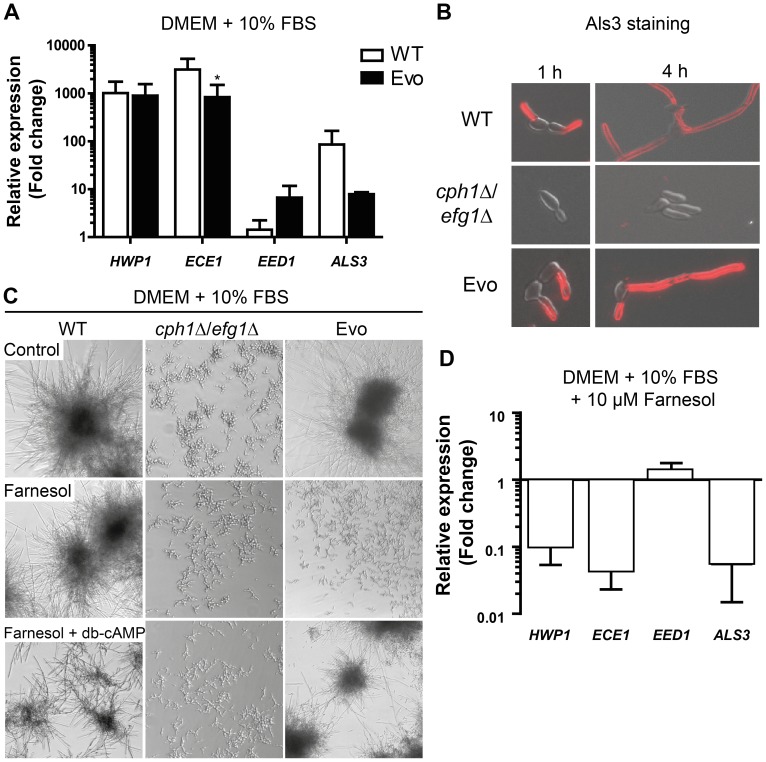
Analysis of hyphae-associated gene expression, Als3 surface expression and response to farnesol.(A) The Evo strain expresses hyphae-associated genes after growth for 1 h at 37°C at 5% CO2 on a plastic surface similar to WT. Relative gene expression of filament-inducing conditions was compared to yeast promoting conditions (YPD, 30°C) for three independent experiments. Expression was normalized against three housekeeping genes (ACT1, EFB1 and PMA1) and data are shown as mean+SD of three biological experiments (*p<0.05). (B) Immunofluorescence micrographs of cells immuno-stained for Als3 after growth in DMEM+10% FBS at 37°C and 5% CO2 on cover slips. Wild type (WT) and Evo cells are Als3-positive, while cph1Δ/efg1Δ cells show no signal (representative samples). (C) Morphogenetic response to farnesol treatment alone or in combination with exogenous dibutyryl-cyclic AMP (db-cAMP). All strains were exposed to either methanol (control), 1 µM farnesol or 1 µM farnesol+10 mM db-cAMP and incubated at 37°C and 5% CO2 for 18 h (representative pictures from three independent experiments are shown). Note that in Evo cells inhibition of filamentation by farnesol treatment was completely abrogated when db-cAMP was added. (D) Repression of hyphae-associated gene expression in the Evo strain by 10 µM farnesol. Expression was normalized against three housekeeping genes (ACT1, EFB1 and PMA1). The fold change in expression relative to filament-inducing conditions alone is shown as mean+SD of three biological experiments.